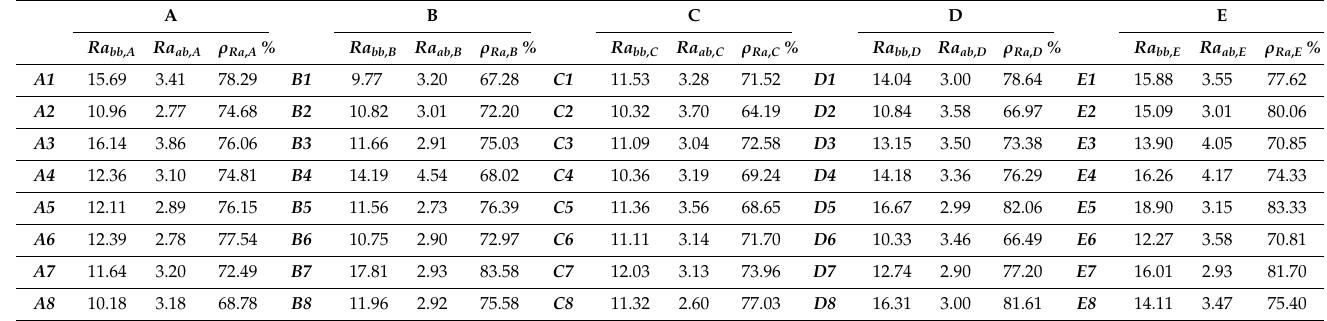
Table 3. The measured values and the calculated improvement ratios for Ra [ µ